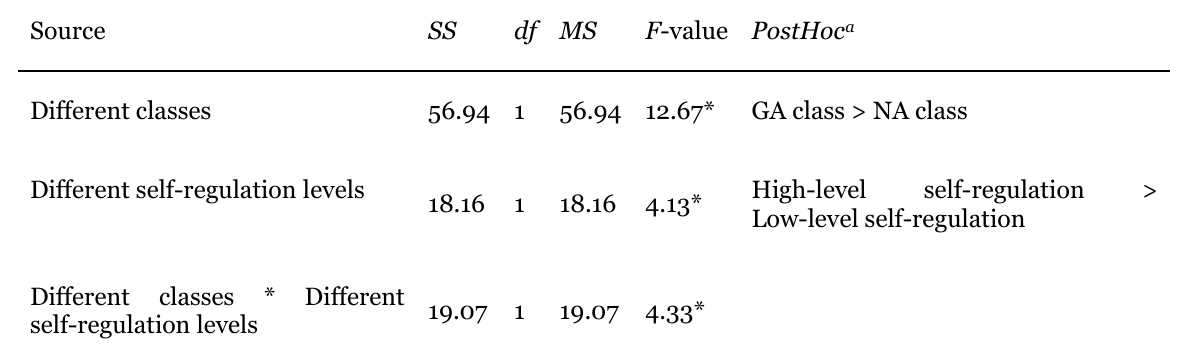
Two-Way ANOVA of the Number of Taking Assessments (n = 99)